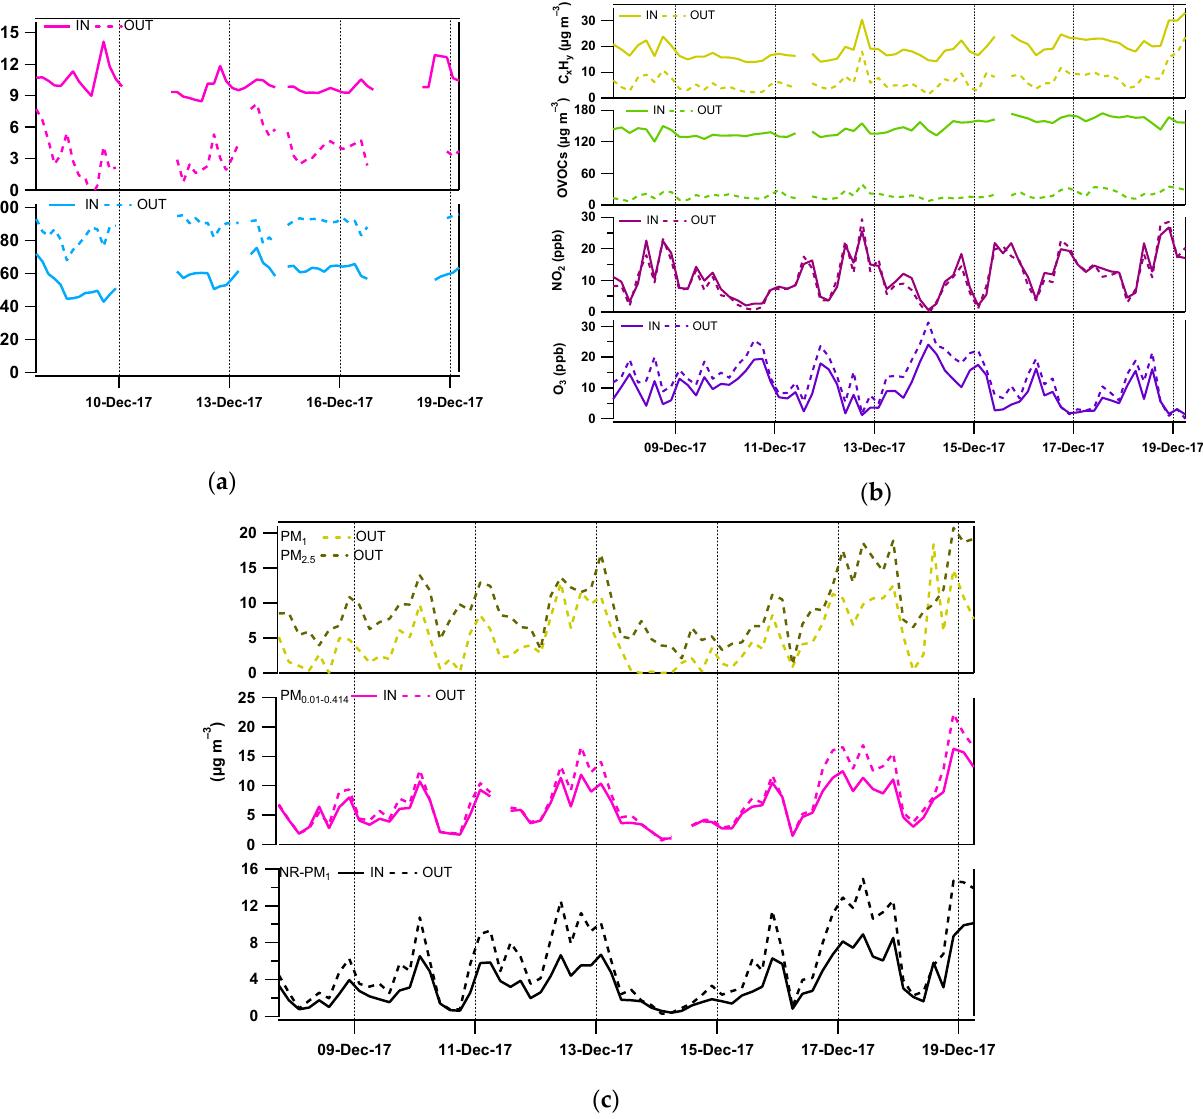
Figure 2. Timeseries of ( a ) meteorological parameters, ( b ) gas phase compounds, and ( c , from top to bottom) particle mass concentrations monitored by TEOM-FDMS, SMPS and AMS indoors (line) and outdoors (dashed line).